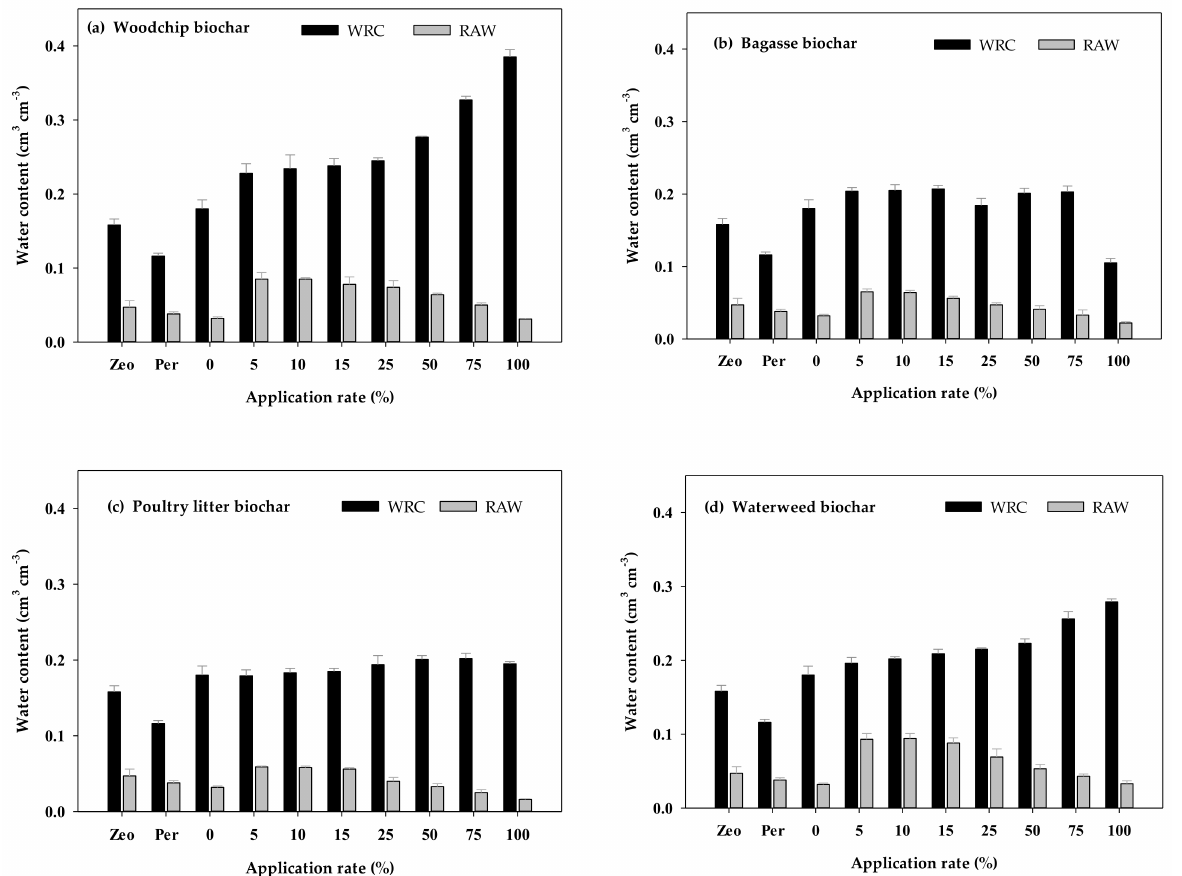
Figure 3. Effect of the biochar rate as well as zeolite and perlite on the water retention capacity (WRC) and the readily available water (RAW) of sandy soil amended with ( a ) woodchip biochar (WBC), ( b ) bagasse biochar (BBC), ( c ) poultry litter biochar (PLBC) and ( d ) waterweed biochar (WWBC) at 0%, 5%, 10%, 15%, 25%, 50%, 75% and 100% biochar